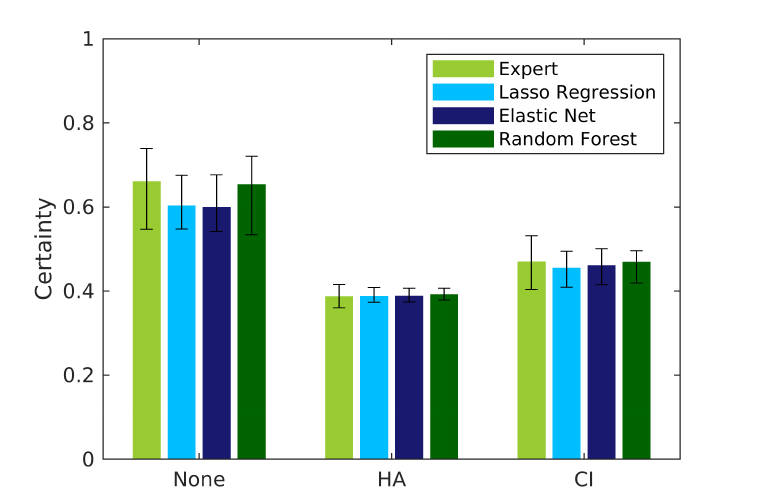
Figure 10. Median and interquartile ranges for certainty of classification in tree set III. Certainties of single CAFPAs are combined according to rel-model weights and propagated through the tree of comparison sets. Each bar represents patients that were classified to their respective category using expert-estimated or predicted CAFPAs (color-coded). Table A2 summarizes certainty results for the remaining tree sets and